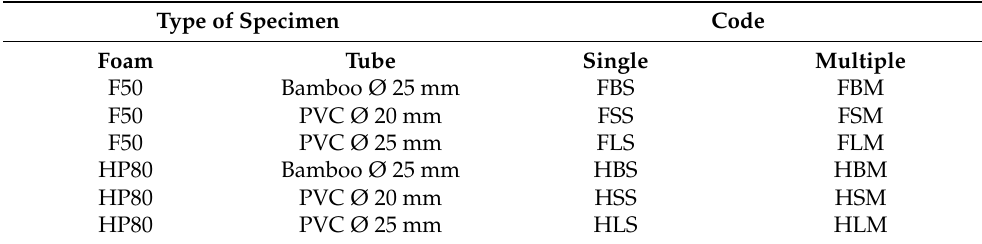
Table 2. Code used for the tube reinforced foam structures.